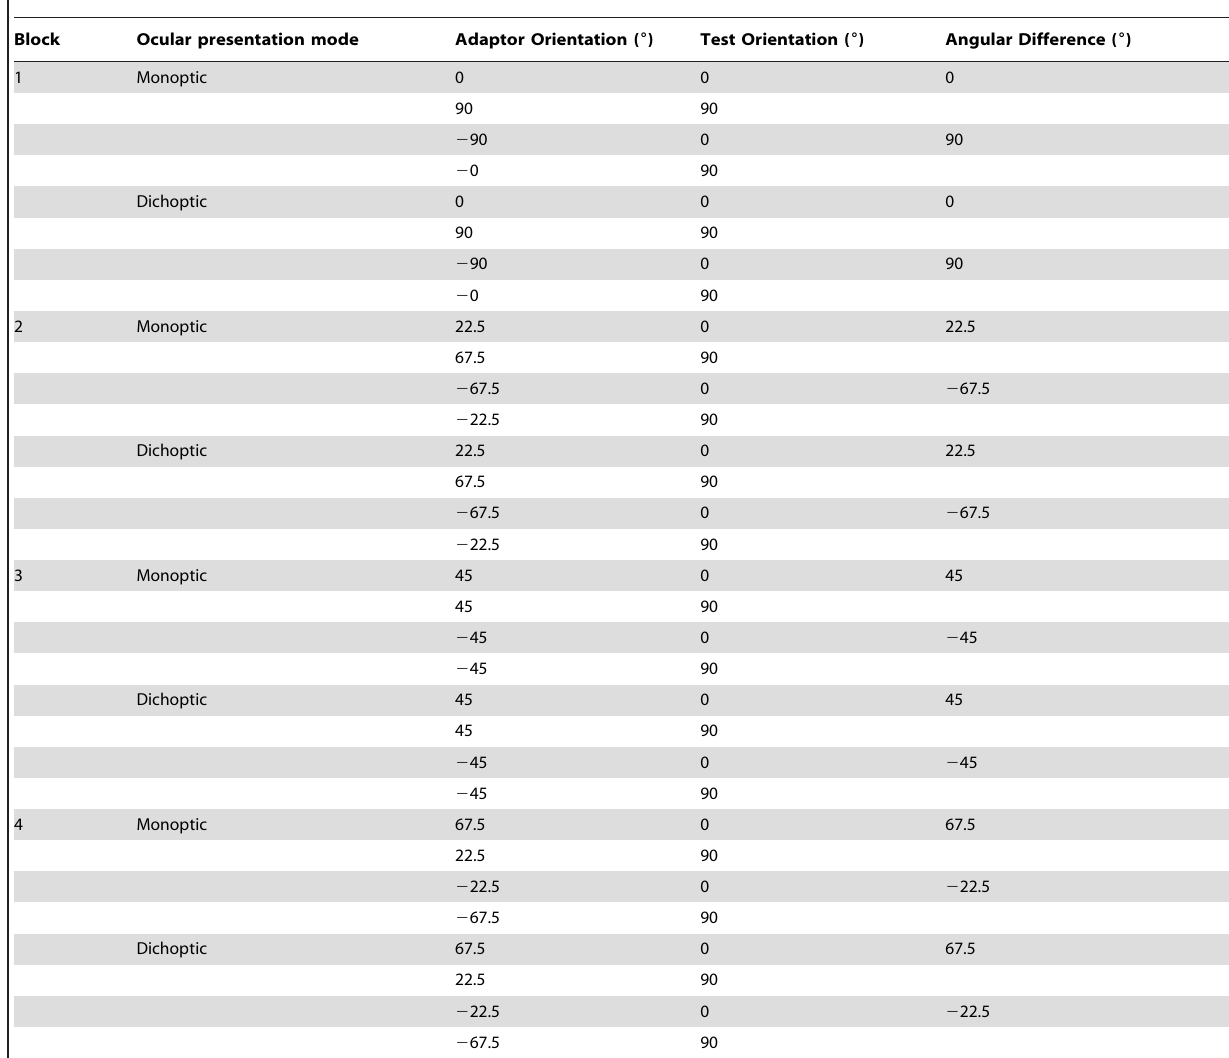
Table 1. 32 adapt-test pairings, grouped into sixteen conditions according to angular difference and ocular presentation mode.